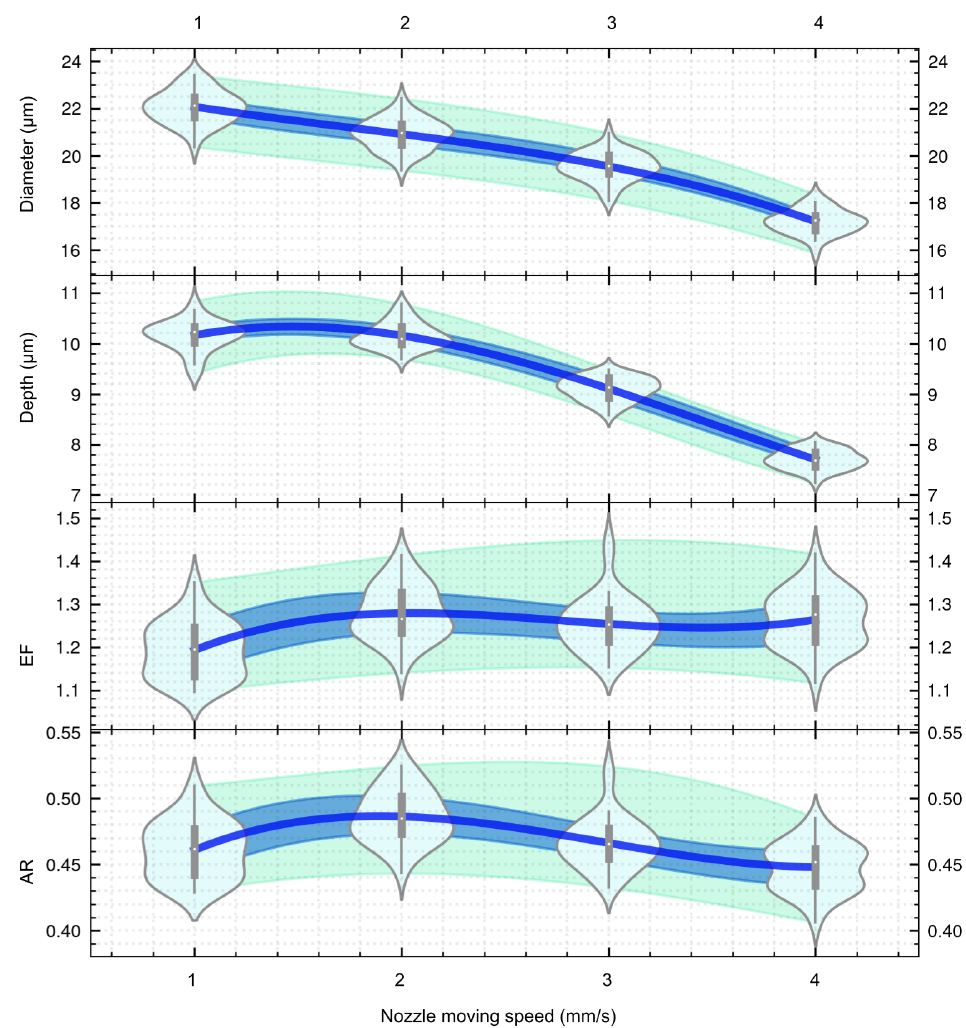
Figure 8. The effect of nozzle moving speed on the dimensions of micro cavities. Table 7. EF and AR of machined cavities with different nozzle moving speed. Speed